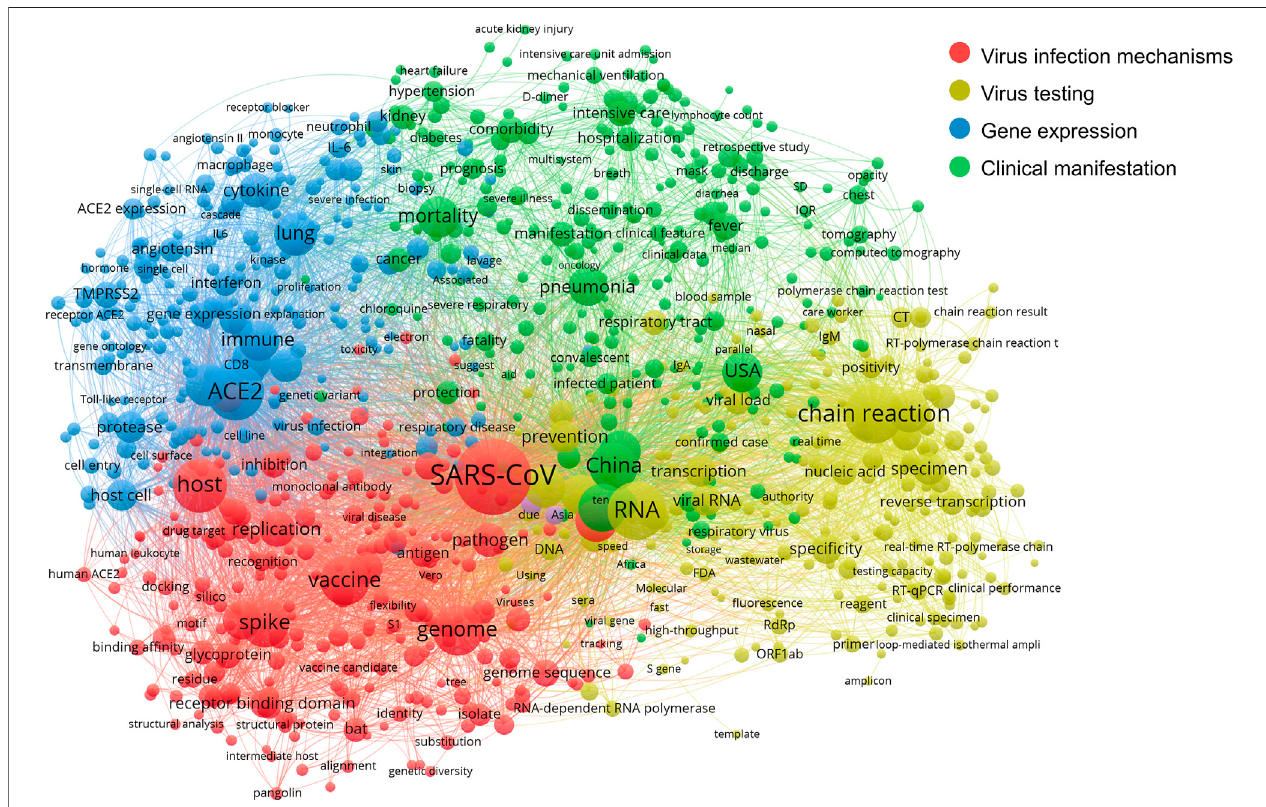
FIGURE 4 | The co-occurrence network of scienti fi c